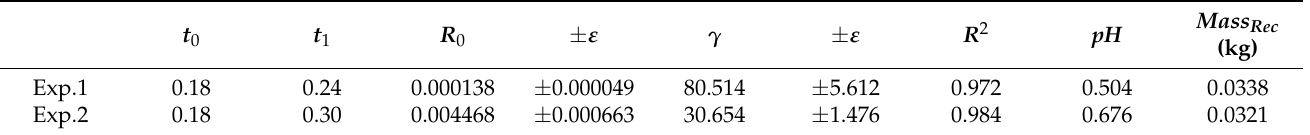
Table 9. Least squares fitting of the exponential model